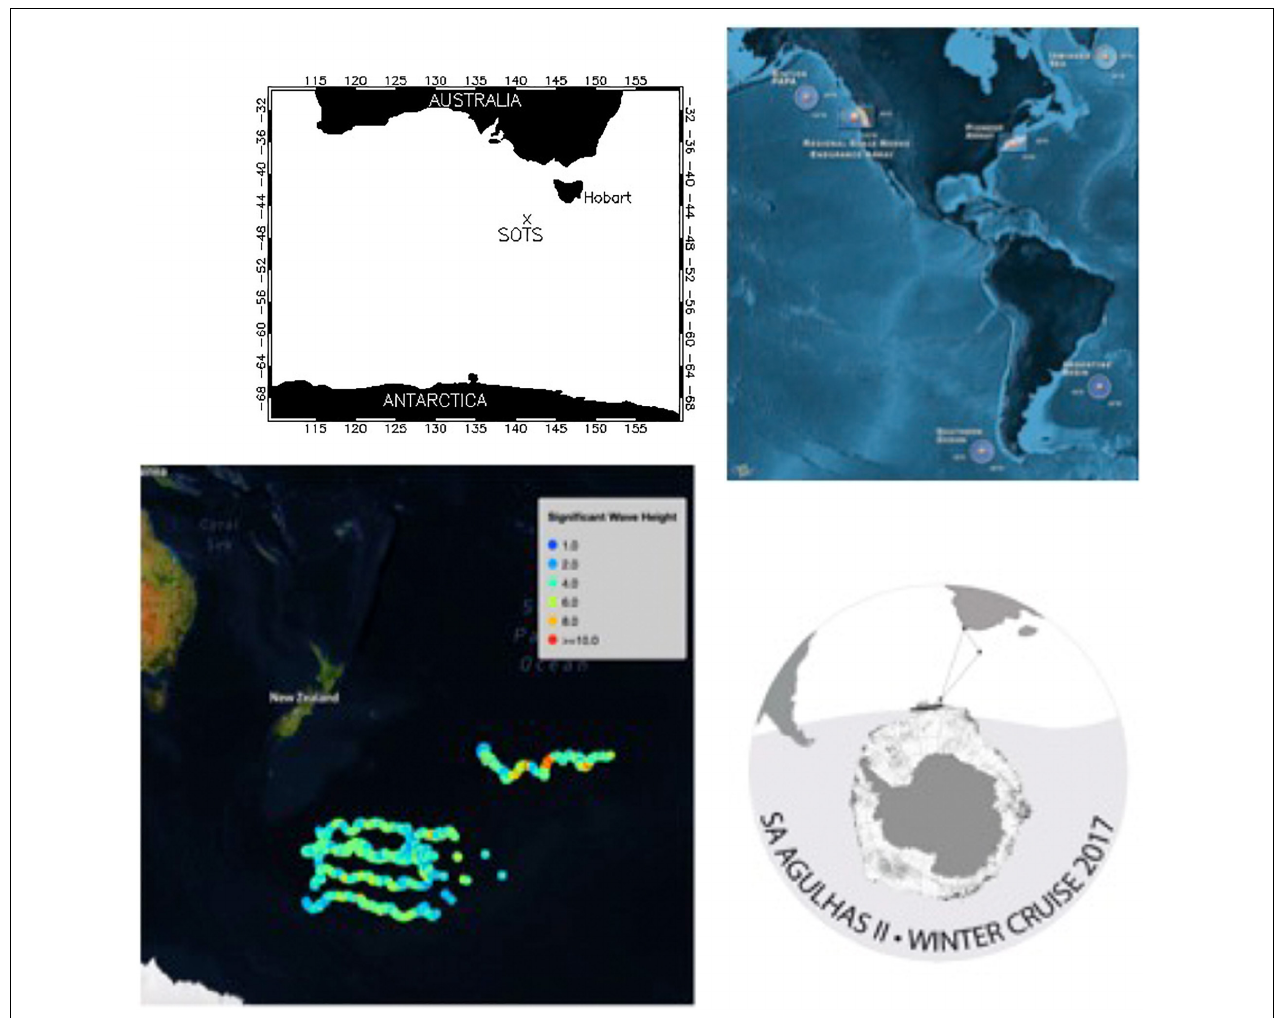
FIGURE 4 | Locations of the Southern Ocean permanent and drifting wave buoys by (top left) Australian Bureau of Meteorology, (top right) United States NSF Ocean Observatories Initiative, (bottom left) Metocean Solutions, New Zealand; (bottom right) SA Agulhas II 2017 winter